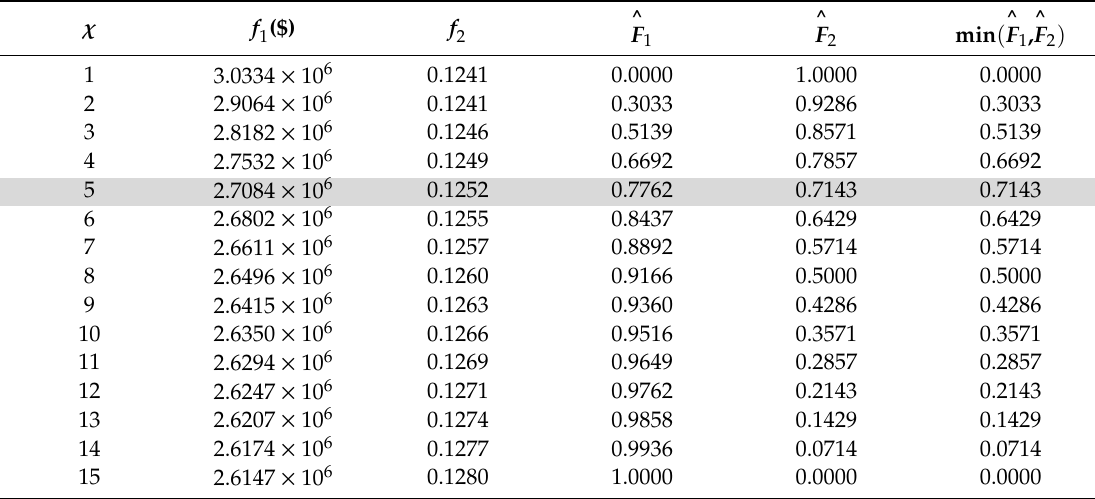
Table4. ObtainedParetooptimalsolutionsforthedeterministicmulti-objectiveRPPwithoutconsidering the loadability